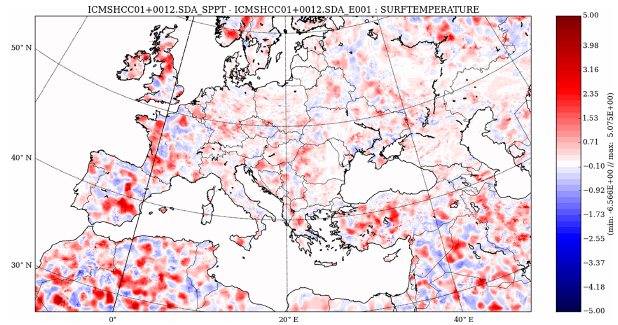
Figure 3. An example case of the Surface temperature perturbation by ESDA method (perturbed observation analysis minus reference analysis for one ensemble member).